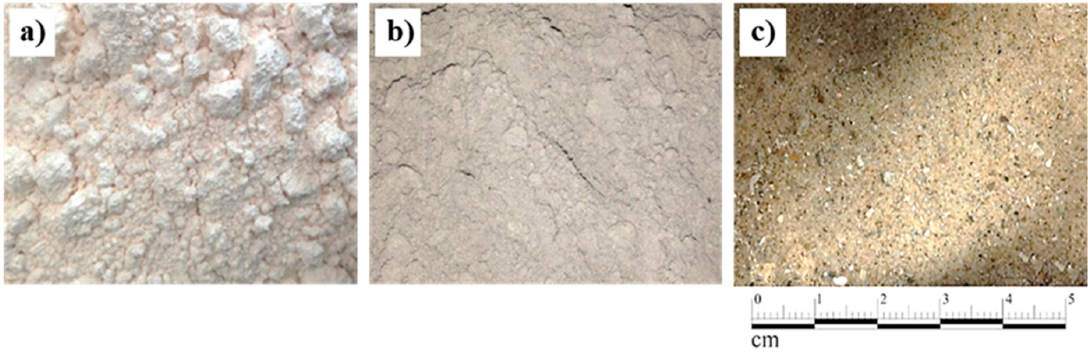
Figure 1. Visual aspect of ( a ) metakaolin, ( b ) biomass ash, and ( c ) river sand. Table 1. Chemical composition (wt%) of kaolin and biomass ash measured by X-ray fluorescence (XRF). Material